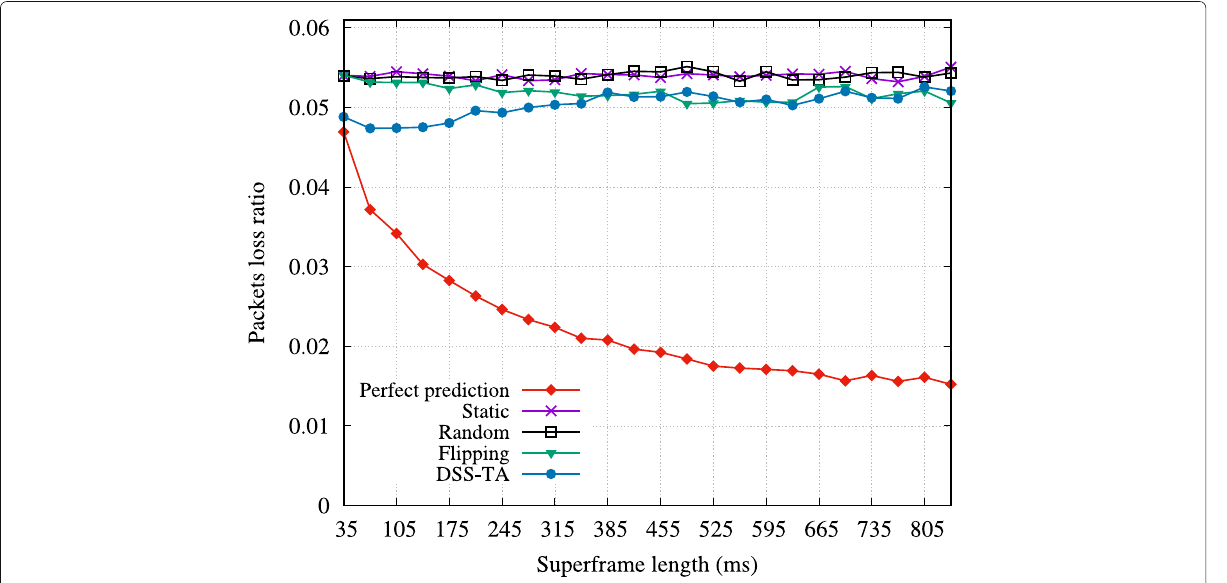
Fig. 14 PLR vs. superframe length, P Tx = –15 dBm, CD 1